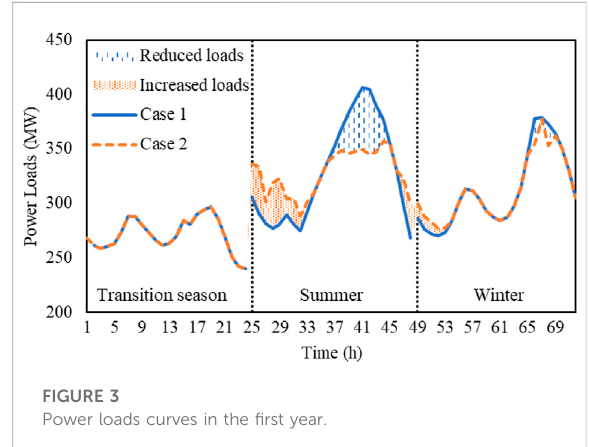
FIGURE 3 Power loads curves in the fi rst